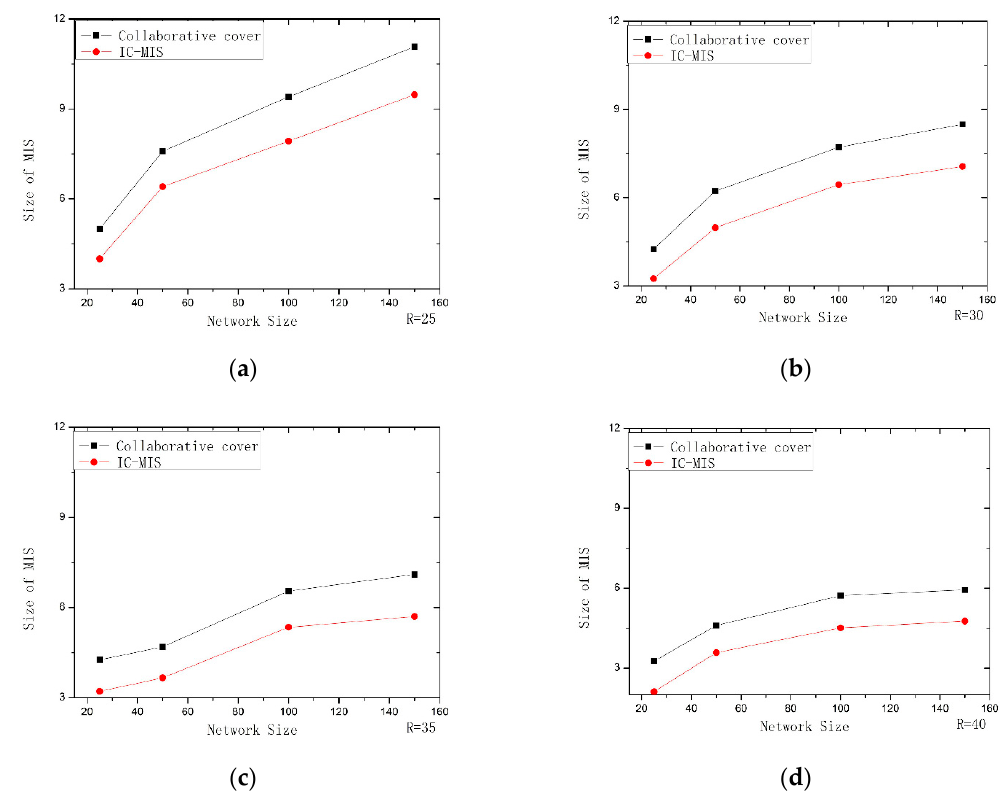
Figure 7. Performance comparison of IC-MIS with Collaborative coverage: ( a ) R = 25; ( b ) R = 30; ( c ) R = 35; ( d ) R =